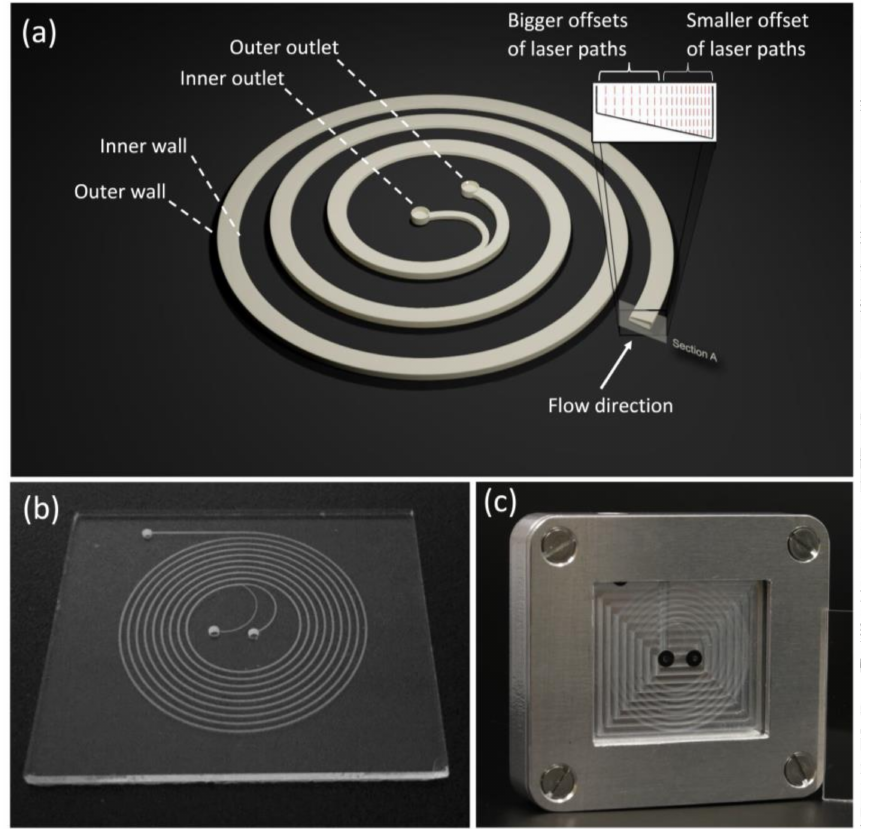
Figure 1. Design of the spiral microfluidic chip and the final fabricated platform ( a ) illustration of the proposed trapezoidal spiral microfluidic channel design with one inlet and two outlets, larger and smaller radial increments as used for the laser ablation providing a sloped channel bottom are illustrated in the insert, ( b ) ready-made and bonded glass platform of the spiral channel, and ( c ) spiral microfluidic chip inside the aluminum holder for easier inlet/outlet tube